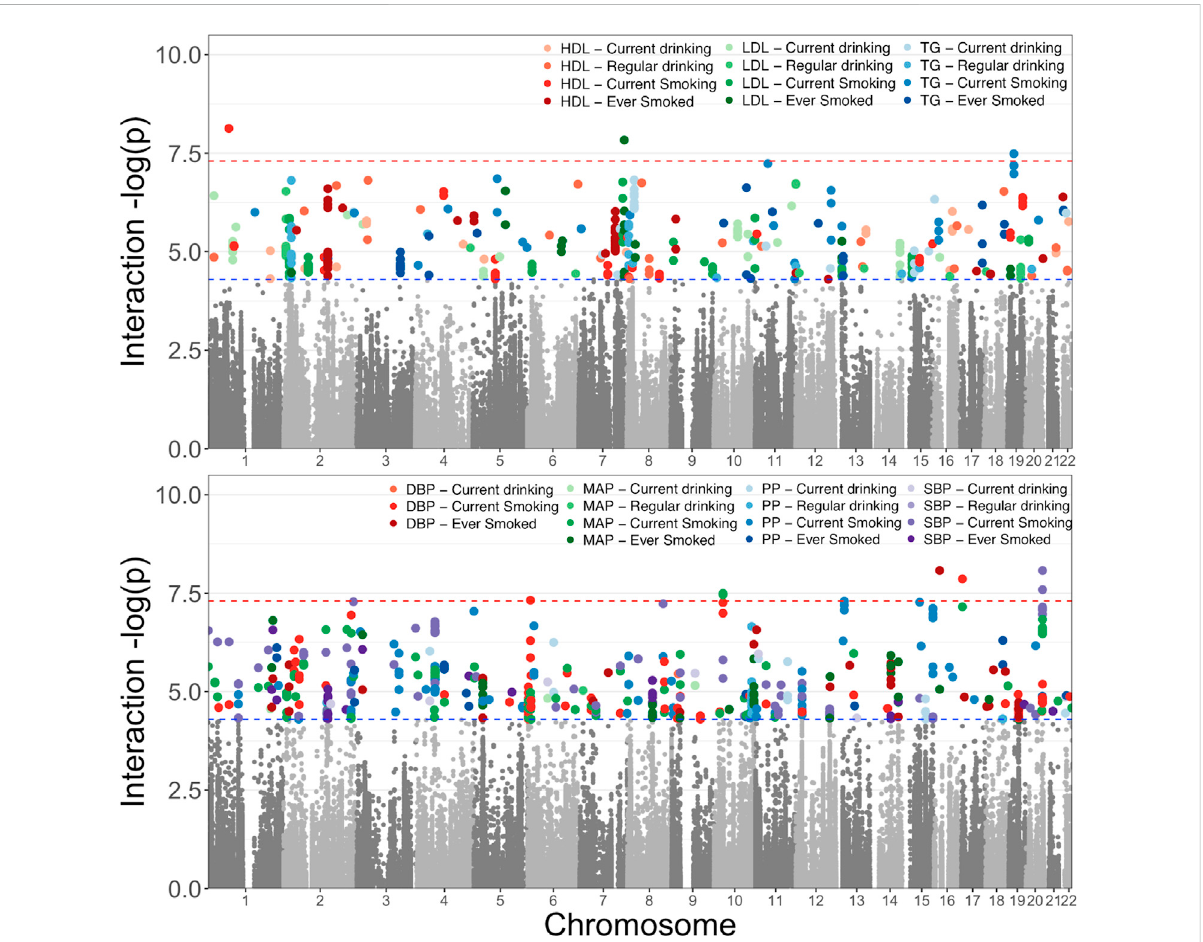
FIGURE 2 Selection of GLI Associations for Evaluation; a total of 897 variants were selected from meta-analyses of four ancestral groups and one trans- ancestry group of the variant interactions with two smoking and two alcohol exposure variables on three lipid measures (top fi gure) and four blood pressure traits (bottom fi gure). Here we show the most statistically signi fi cant associations across the fi ve meta-analyses for each of the phenotype- exposure combinations. The results separated by ancestry group are available in Supplemental Figure